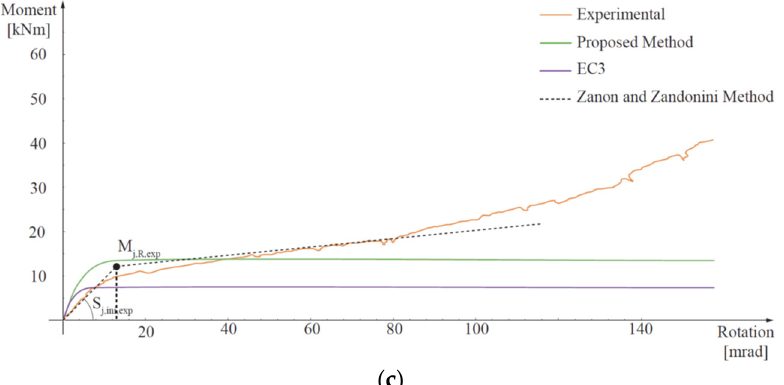
Figure 8. Comparison of moment-rotation curves obtained using Eurocode 3 (EC3) and proposed methods with the experimental ones [29] (solid lines) and estimation of the experimental pseudo- plastic moment resistance ( M j , R , exp ) (black dot) by means of Zanon and Zandonini method [42] (dashed lines): ( a ) Extended End-Plate (EEP), ( b ) Flush End-Plate (FEP), ( c ) Top-and-Seat Angle Cleat connection (TSAC).